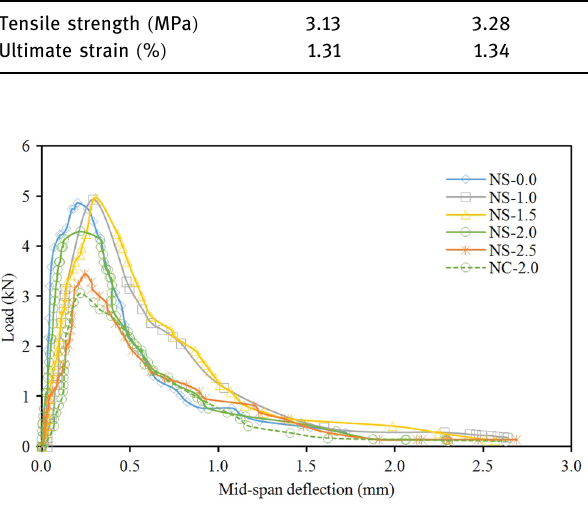
Figure 7: E ff ect of nanoparticles on the relation curve of load and midspan de fl ection.